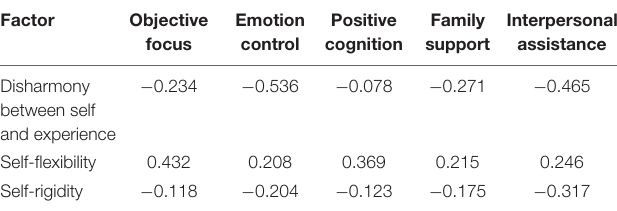
TABLE 6 | Correlation matrix between college students’ mental toughness and self-harmony.